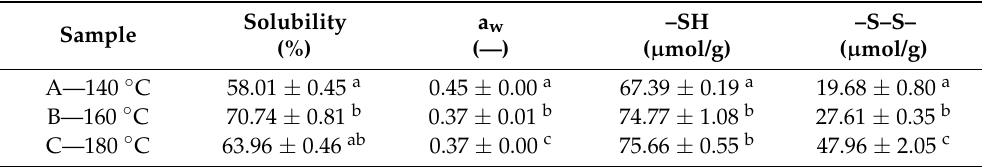
Table 2. The effects of spray-drying conditions on solubility, water activity and changes in sulfhydryl group (–SH) and disulfide bond (–S–S–) contents of experimental powders. Solubility a w –SH Sample (%) (—) ( µ mol/g)